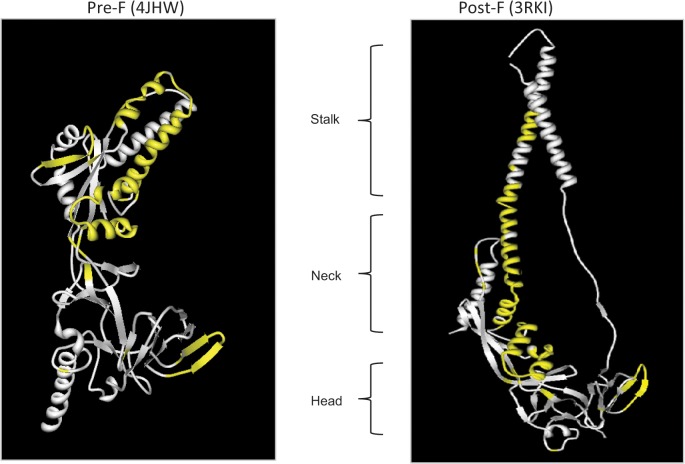
Functional B cell epitopes mapped to F protein.Functional epitopes, comprising 115 total residues, are mapped to the RSV F protein (epitopes are shown in yellow). Three dimensional structures 4JHW (pre-fusion) and 3RKI (post-fusion) were selected to visualize the location of all residues using the IEDB Homology Mapping Tool. This considers all functional (neutralizing and/or protective) linear and conformational epitopes described to date in the literature.